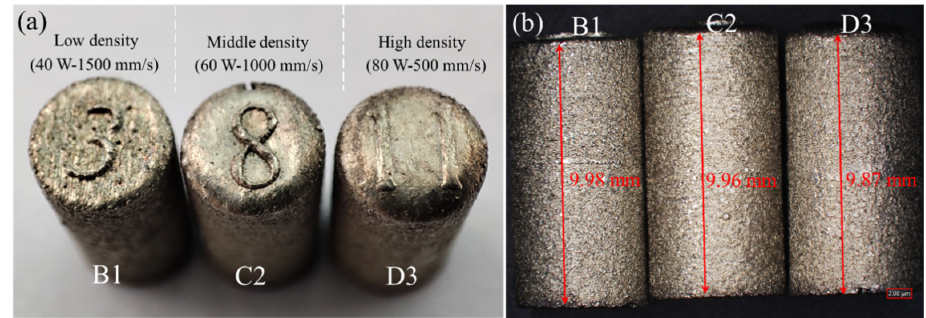
Figure 9. Surface of the as-printed Sn58Bi alloy specimens in different energy densities: ( a ) top view, ( b ) side view.